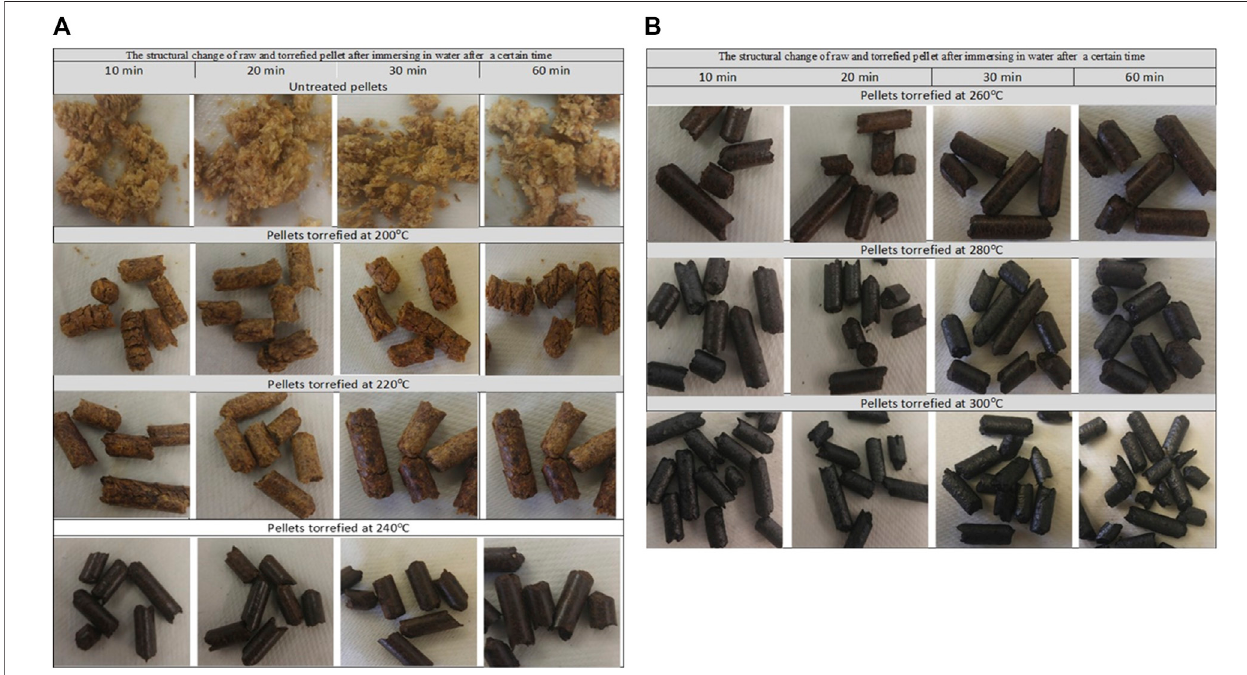
FIGURE 4 | (A, B) Physical appearance of non-torre fi ed and torre fi ed pellets after immersion in water for 10 – 60 min (Ghiasi,